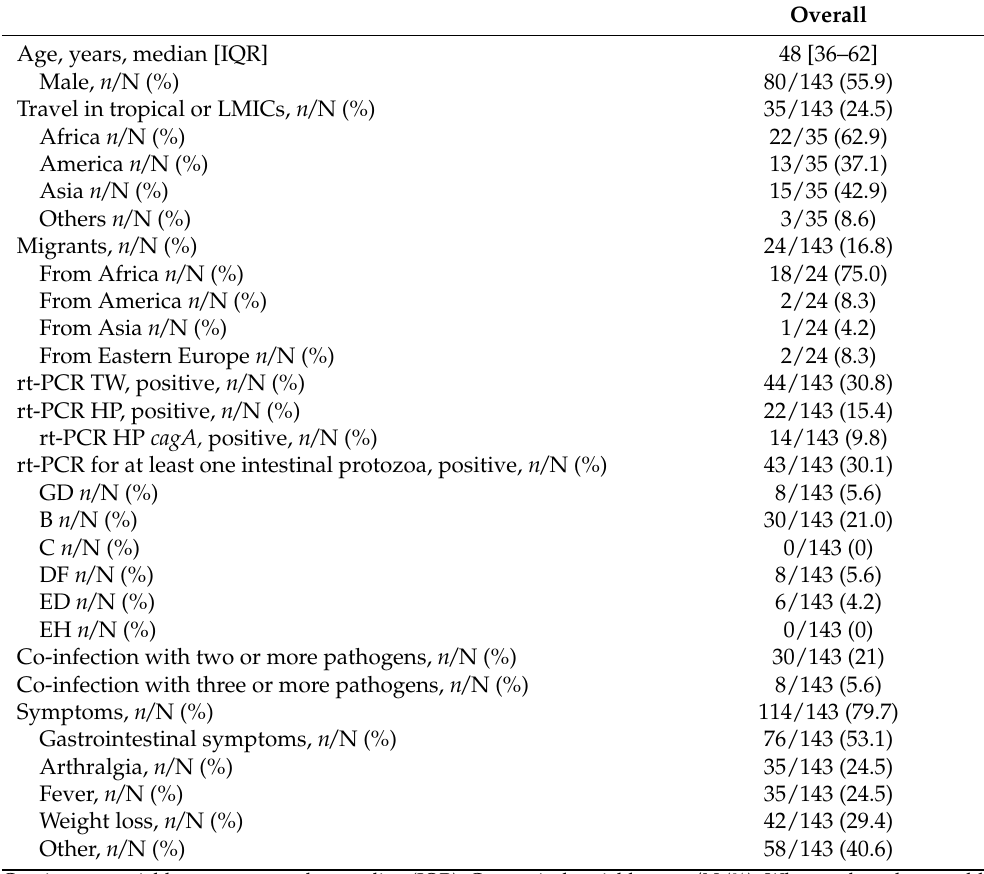
Table 1. Demographic data, risk factors, rate of infections (TW, HP, and protozoa), and symptoms of the overall population ( n = 143). TW, T. whipplei ; HP, H. pylori ; GD, G. duodenalis ; B, Blastocystis spp. ; C, Cryptosporidium spp. ; DF, D. fragilis ; ED, E. dispar ; EH, E. histolytica ; LMICs, low- and middle-income countries; IQR, interquartile